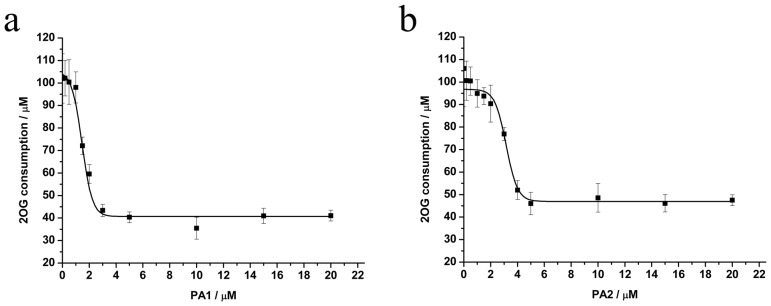
Effects of a PA1 and b PA2 on hydroxylation of PHD3.Incubations were carried out at the KM of HIF-1α peptide substrate and a saturating concentration of 2OG, with increasing compound concentration (0–20 µM). EC50 values were estimated by dose regression of initial velocity versus compound concentration. Data are presented as mean ± S.D. of three independent experiments.